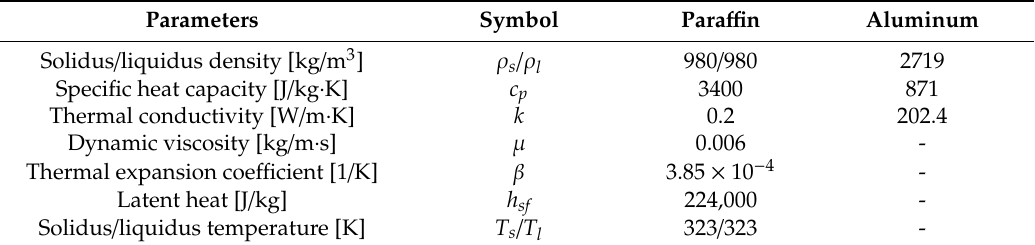
Solidus / liquidus temperature [K] T s / T l 323 /